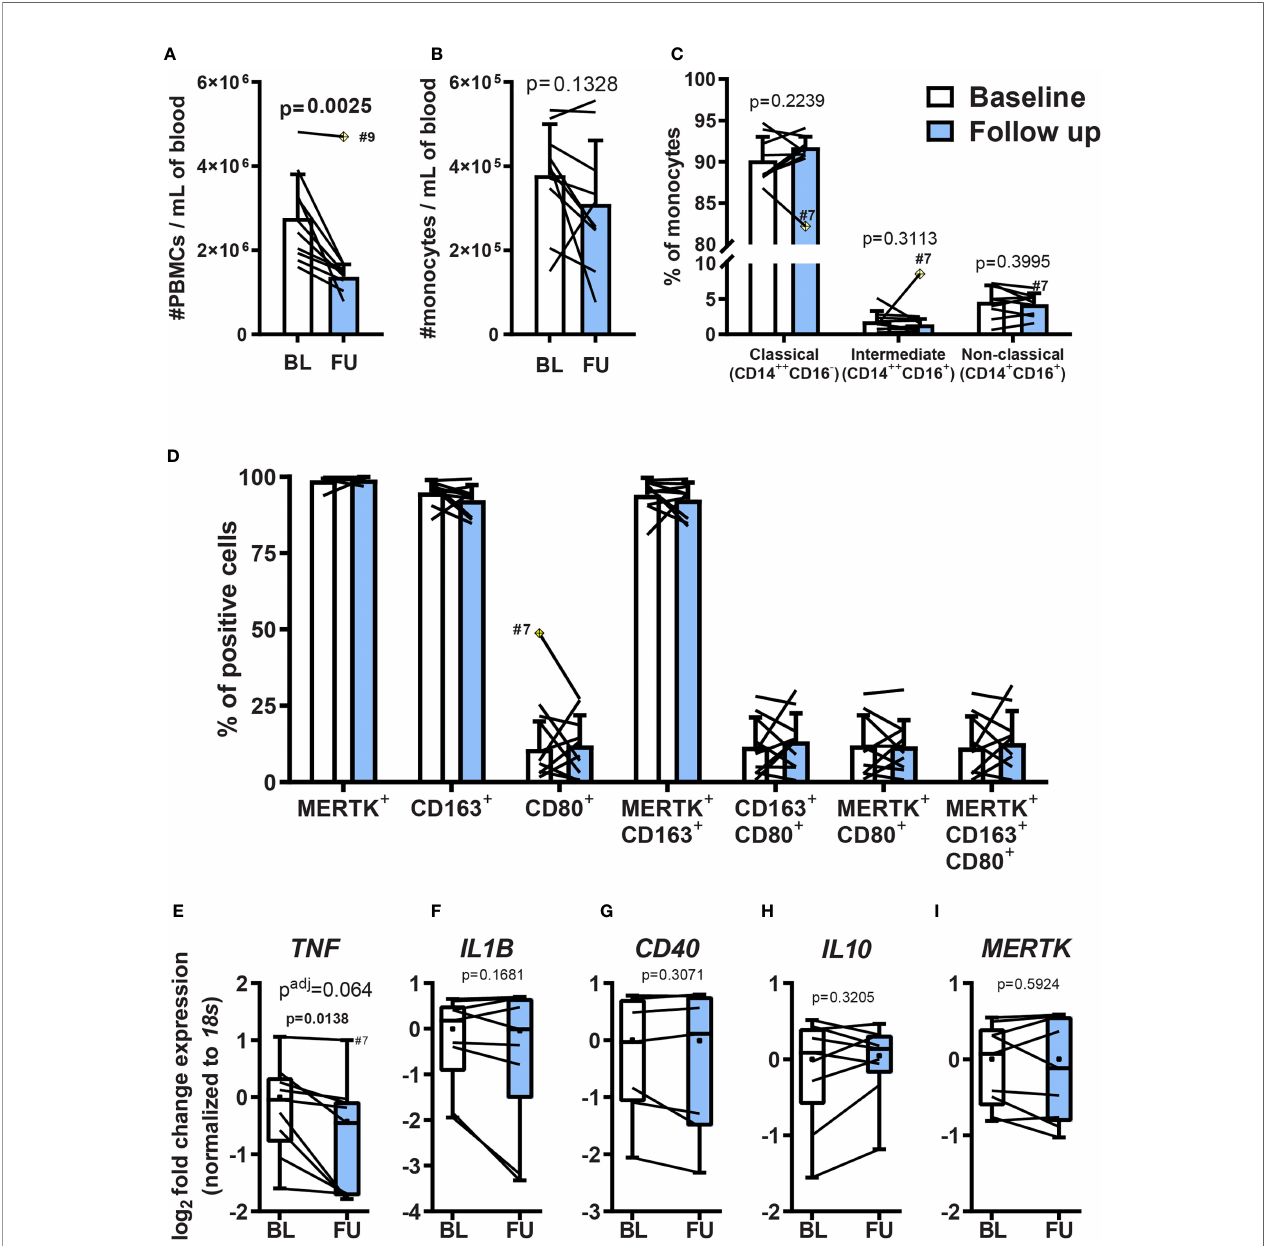
FIGURE 2 | Effects of oral cladribine treatment on circulating PBMCs from MS patients and monocyte ex vivo differentiation. Monocytes isolated from MS patients ’ PBMCs before (white) and 19-21 days after (blue) the beginning of cladribine treatment were differentiated to MDMs for 7 days with M-CSF. (A) The density of peripheral blood mononuclear cells (PBMC) in blood collected from MS patients before (BL; baseline) and 19-21 days after (FU; follow up) the beginning of cladribine treatment. (B) The density of MACS-isolated monocytes from freshly isolated PBMCs of MS patients before (BL; baseline) and 19-21 days after (FU; follow up) the beginning of cladribine treatment. (C) Monocyte subsets from cladribine-treated MS patients before (white) and 19-21 days after (blue) the beginning of cladribine treatment were determined by CD14 and CD16 surface expression, as analyzed by fl ow cytometry. (D) MDMs of cladribine-treated MS patients were differentiated for 7 days with M-CSF and the expression of pro-in fl ammatory (CD80) and anti-in fl ammatory (CD163 and MERTK) activation markers were analyzed by fl ow cytometry. (E – I) Gene expression of activation markers in monocyte-derived macrophages (MDM) from cladribine-treated MS patients. RT-qPCR gene expression analysis of pro-in fl ammatory (E – G) and anti-in fl ammatory (H, I) activation markers. Positive cells were determined according to (C) isotype controls and (D) FMO controls. (A – D) Data depicted as mean (with SD) and lines indicate before-after cladribine treatment, (A, C) n=9, (B – I) n=10. The yellow crossed diamond shows the statistically signi fi cant outlier (ESD, extreme studentized deviate method), which was excluded from the analysis. (A – D) Statistical signi fi cance was calculated with paired t-test. (E – I) Data depicted as median (with quartiles, dot indicates mean), lines indicate before-after cladribine treatment, n=9 (patient #9 was not included due to technical problems). (E) n=8, the outlier value #7 follow up (ESD method) was not included in the analysis. (E – I) p-values between baseline and follow up were determined by paired t-test and the adjusted p-value (p adj ) was calculated using the posthoc Holm-Sidak correction for multiple